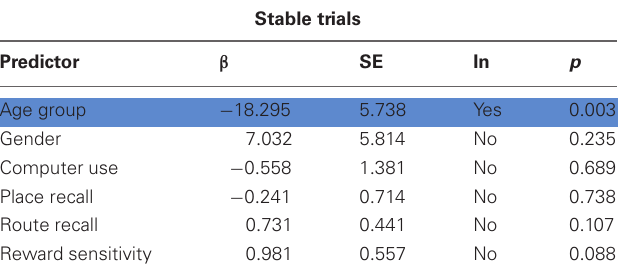
Table 3 | Results of stepwise regression analysis predicting stable trials, with significant predictors (age group) highlighted in blue.